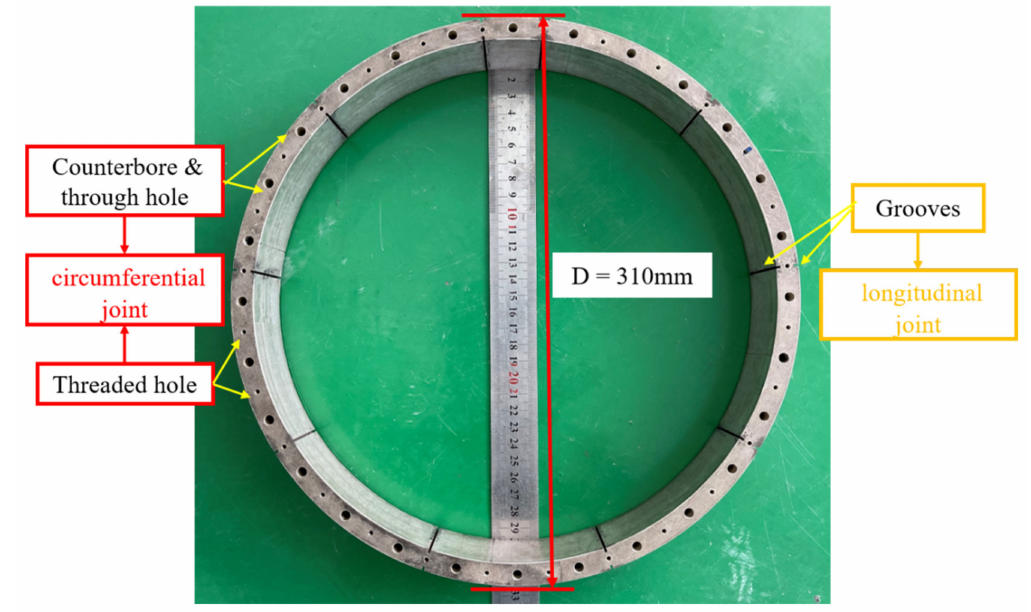
Figure 3. Model lining